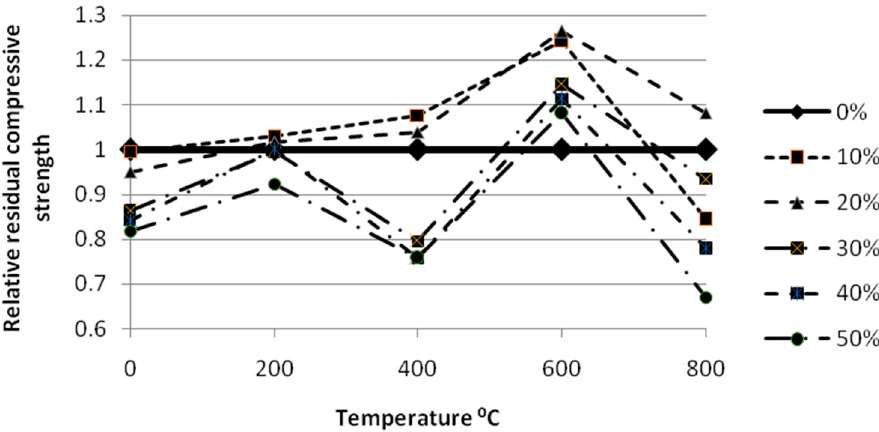
Figure 11. Relative residual compressive strength of gradually cooled SCGM at high temperature.